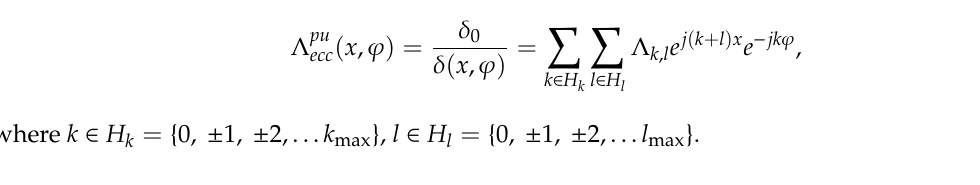
electrical angle α of the magnetizing current